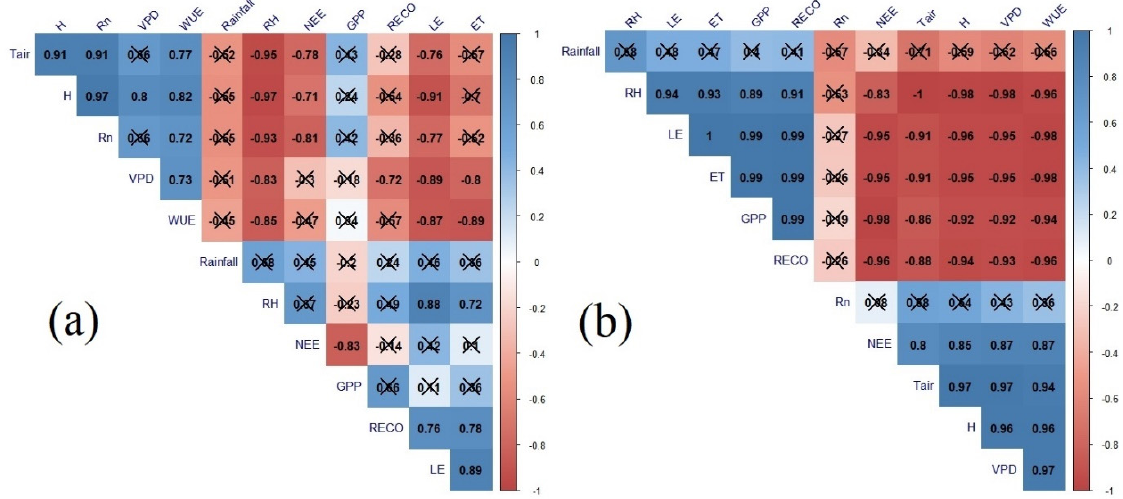
Figure 7. Heatmap based on the correlation matrix between gross primary production (GPP) and the other water and energy flux variables, and meteorological variables in the dry season ( a ) and wet season ( b ) of 2014 and 2015 in the Caatinga (ESEC-Seridó). Warm colors represent positive correlation and cold colors represent negative correlations. Crossed-out values were not statistically significant ( p -value > 0.05).